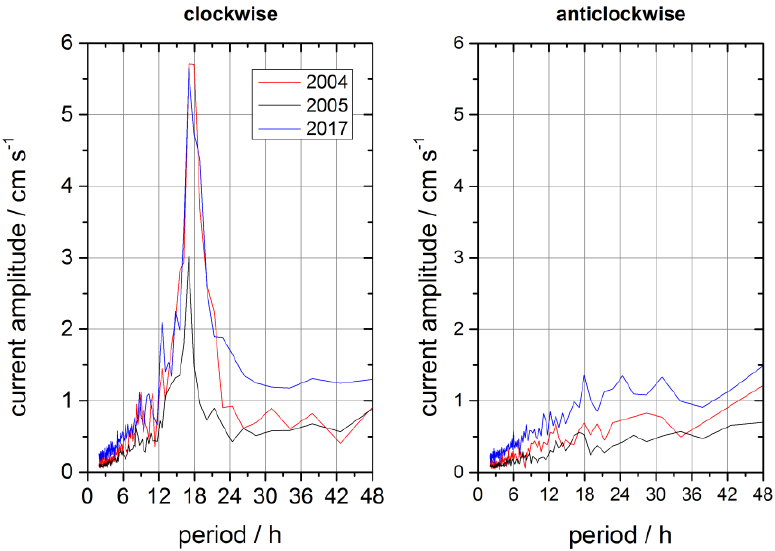
Figure 15. Comparison of rotary spectra at the selected cell (clockwise and anticlockwise).